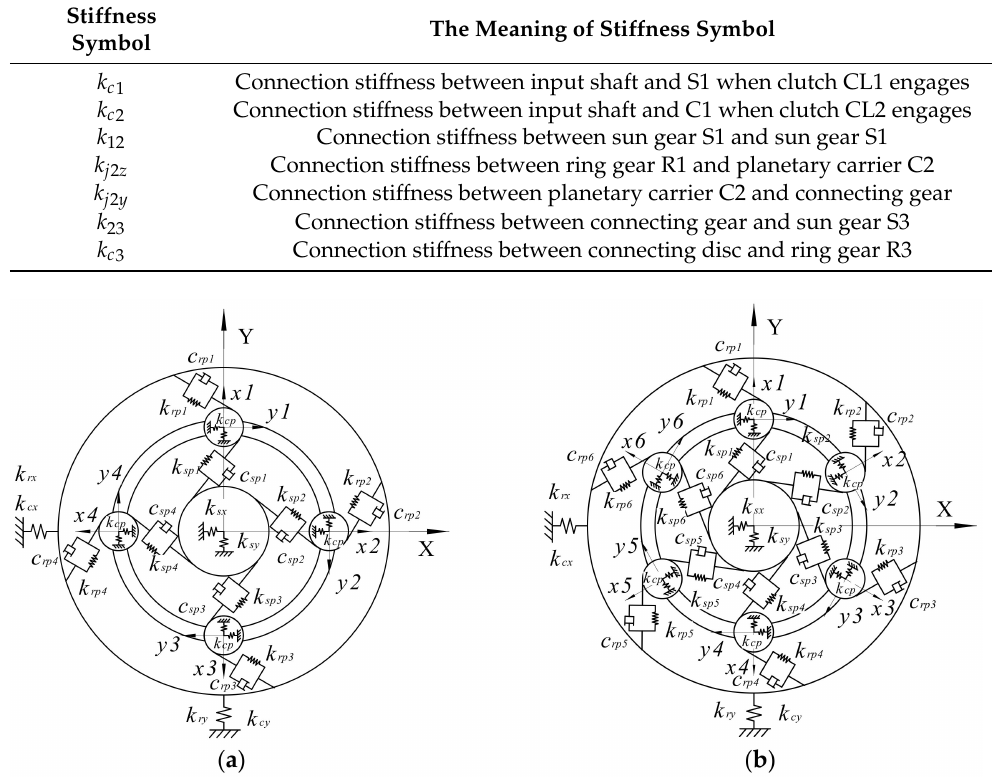
Figure 7. Dynamics model of planetary gear sets. ( a ) Dynamics model of the planetary gear set 1 or 2; ( b ) dynamics model of the planetary gear set